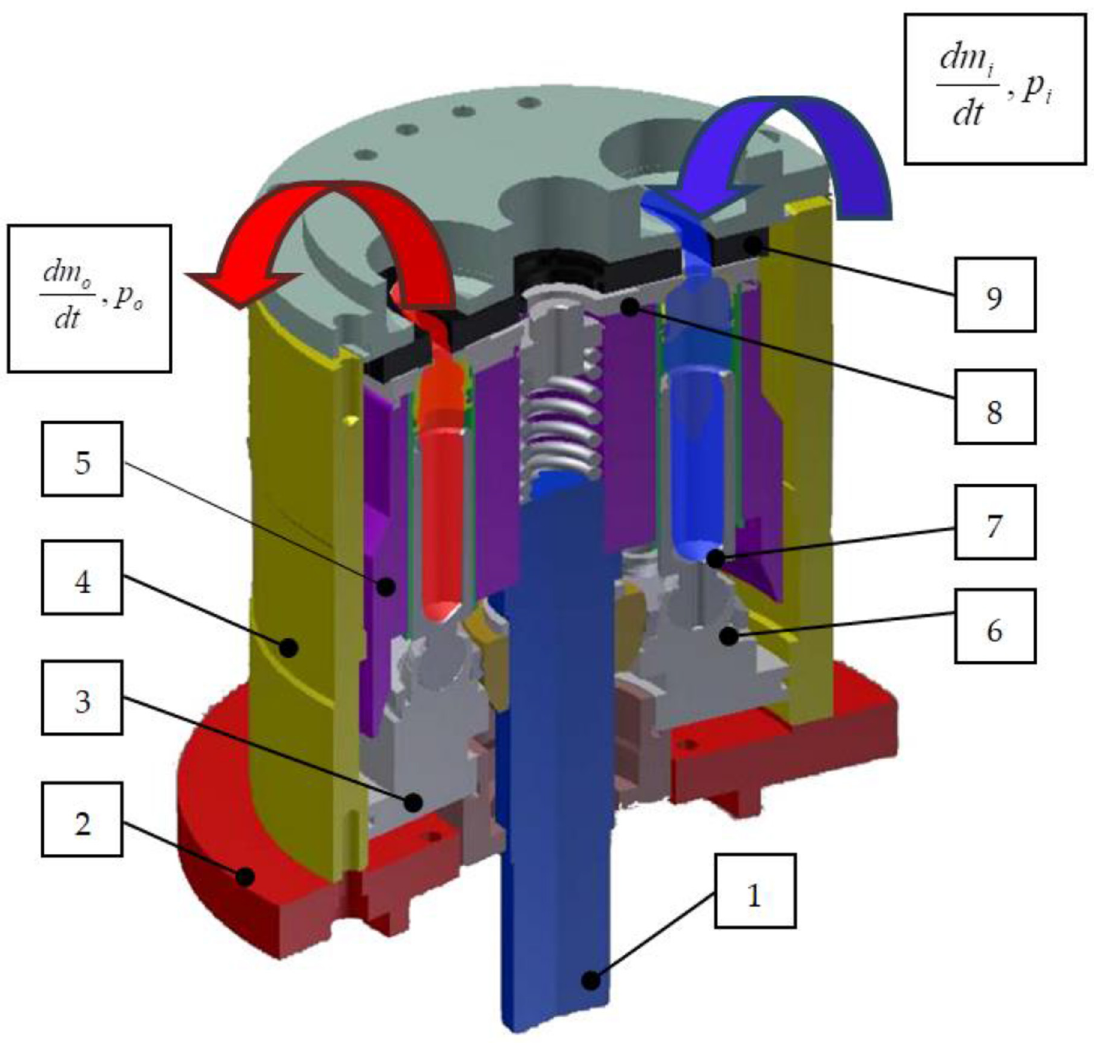
Figure 1. Axial piston pump: 1 . drive shaft, 2 . mounting flange, 3 . swash plate, 4 . bearing housing, 5 . cylinder barrel, 6 . intermediate plate, 7 . piston, 8 . valve plate, and 9 . port plate.